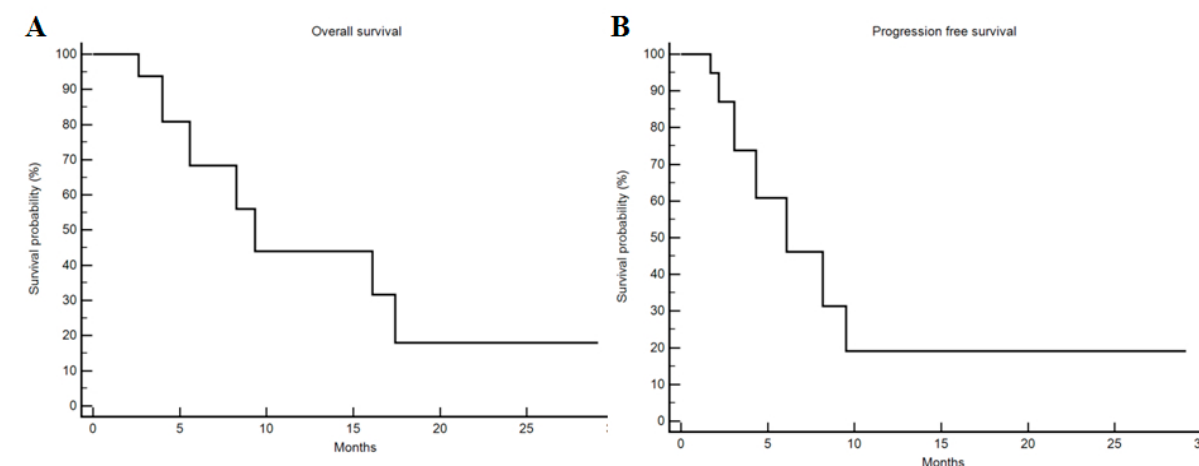
Figure 1. Kaplan–Meier analysis of overall survival and progression-free survival. ( A ) Median overall survival was 9.3 months (95% CI 2.6–17.4). ( B ) Median progression-free survival was 6.1 months (95% CI 1.7–9.5).